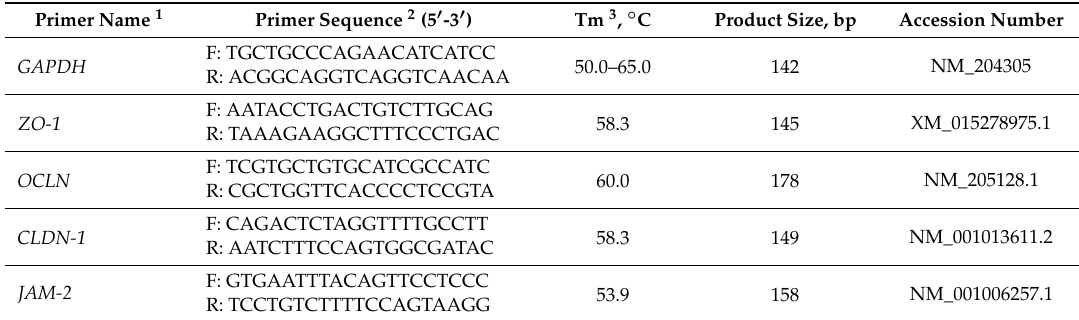
Table 1. Primers used for quantitative